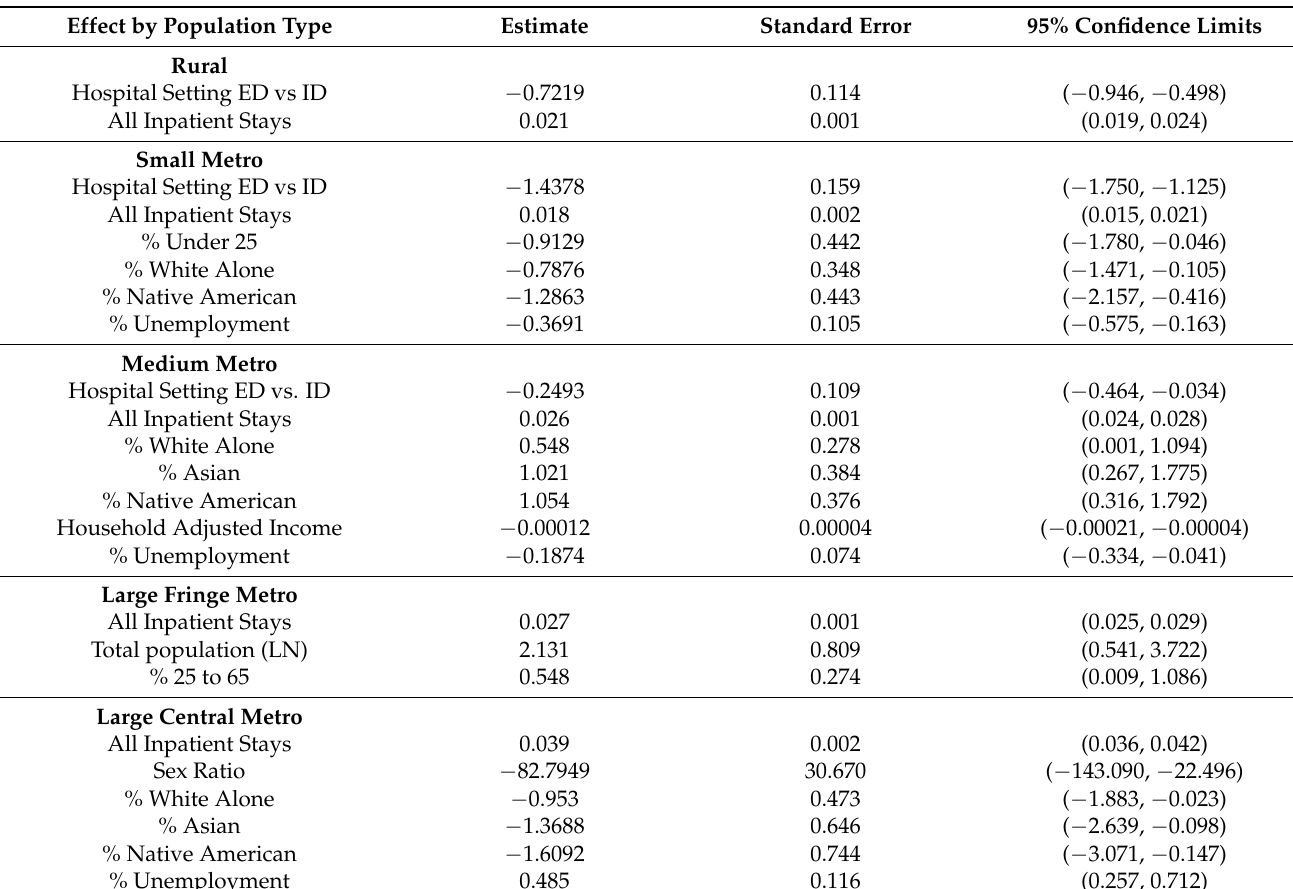
Table 3. A list of demographic variables within each population size for the entire United States that were found to be statistically significant. Values are square root transformed. ED = emergency department discharge. IP = inpatient